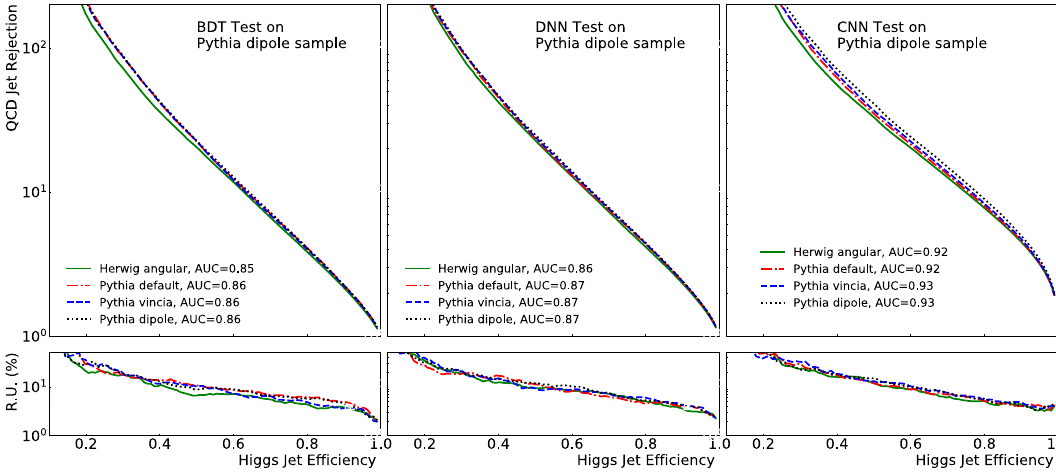
Fig. 10 The QCD rejection (inverse QCD efficiency) as a function of the Higgs jet efficiency for classifiers applied to Pythia dipole jet from four PSMC algorithms. The bottom panel shows the relative